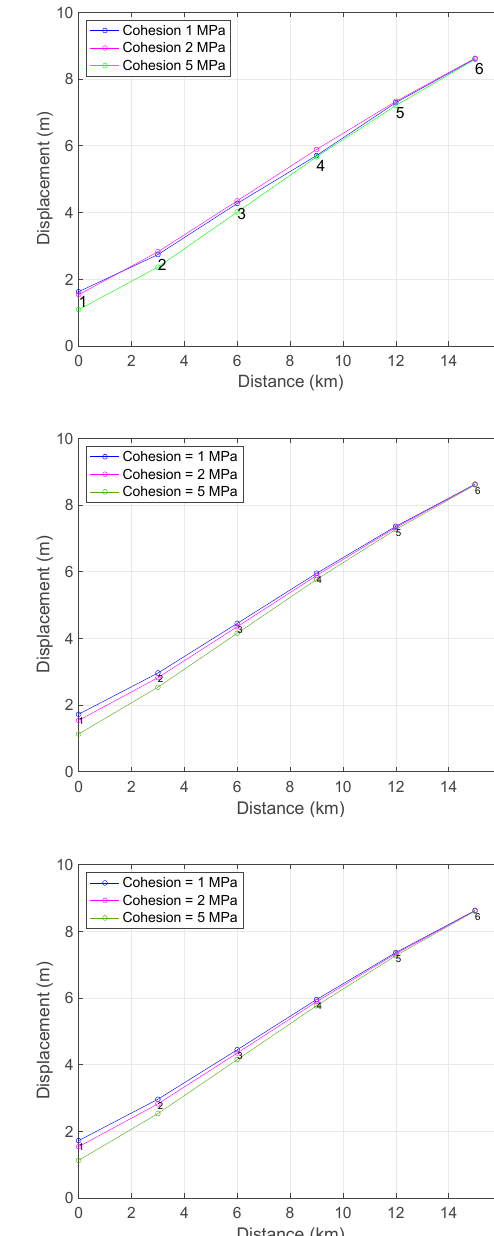
Friction Coefficient = 0.4 Friction Coefficient = 0.6